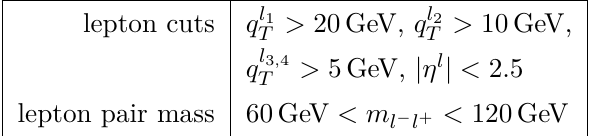
Table 2 . Fiducial volume of the CMS ZZ analysis presented in ref.